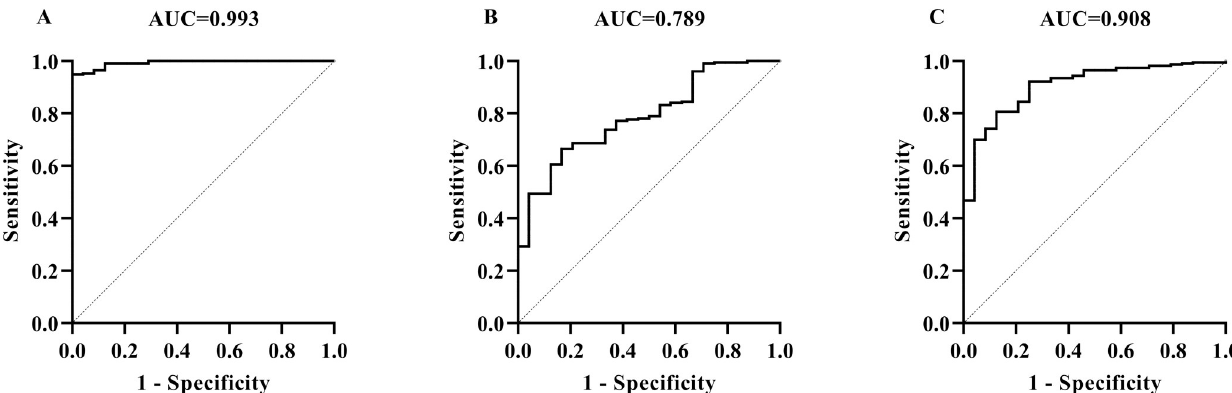
Fig 6. Determination of cut-off values, diagnostic sensitivities, and specificities of MMEC/AG-iELISA for hTB caused by M . tb infection by using the maximum AUC. The ROC curves of MMEC/AG-iELISA for detecting antibodies in serum samples at dilutions of 1:100 (A), 1:200 (B), and 1:500 (C).